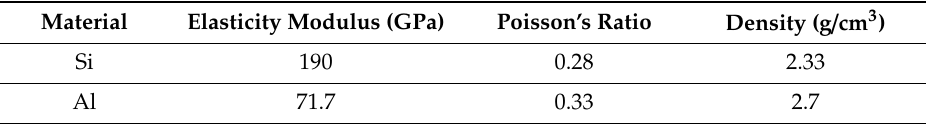
Figure 16. Geometric representation of the contact model: ( a ) Chemical etching model; ( b ) mechanical honing model; ( c ) laser finishing model. Table 3. Material property parameters.